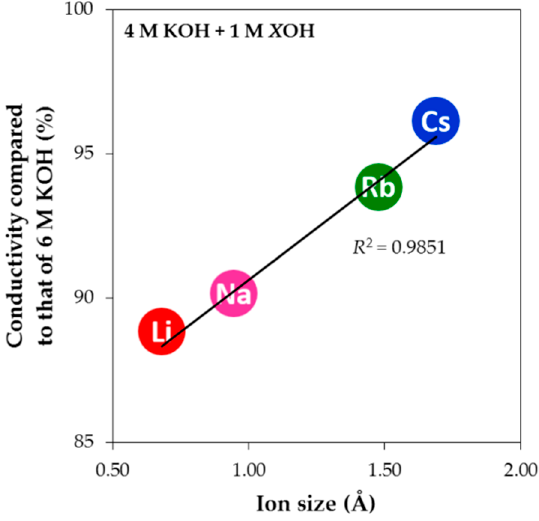
Figure 9. Plot of the conductivities of 4 M KOH + 1 M X OH aqueous solutions normalized to that of 6 M KOH aqueous solution vs. the cation sizes of alkali elements X s.